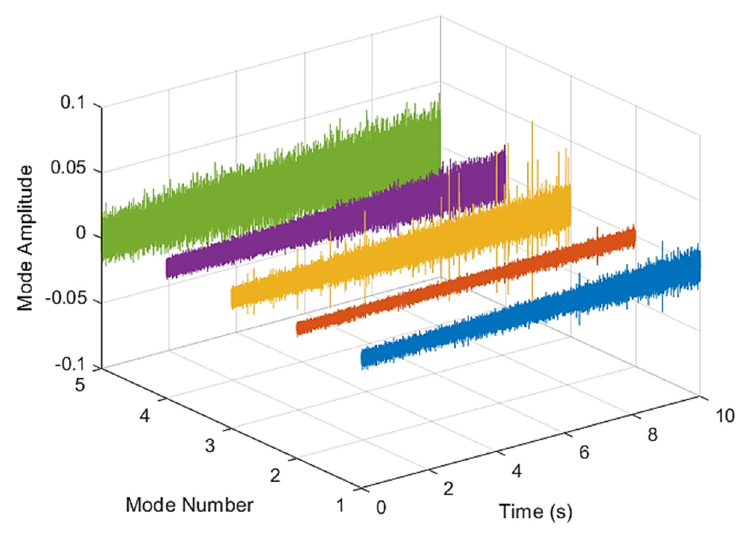
Figure 9. VMD analysis from a ball fault bearing under increasing rotational speed condition in time domain.